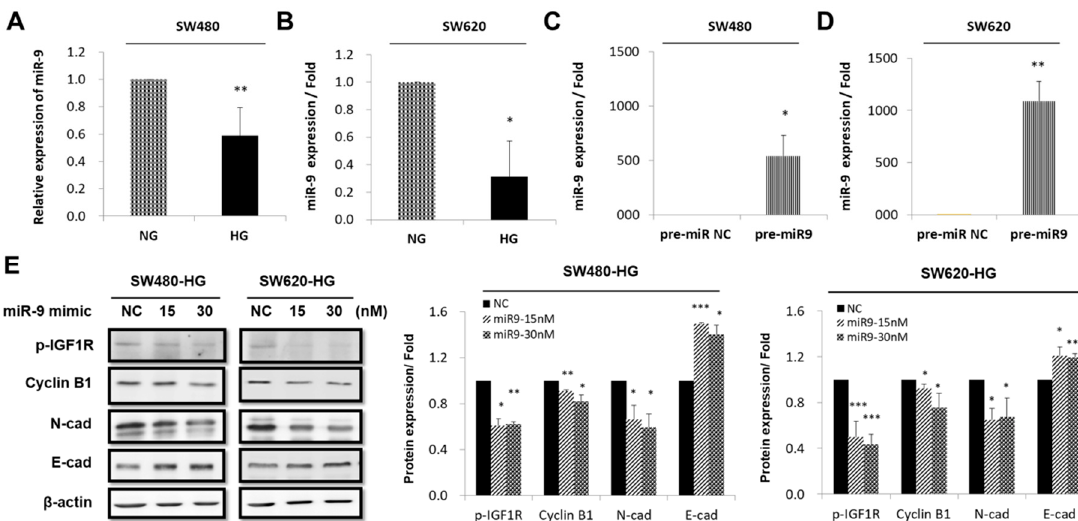
Figure 4. Expression and regulation of miR-9 in colorectal cancer (CRC) cell lines by high glucose (HG) concentration. TaqMan quantitative real-time polymerase chain reaction analysis was performed on miR-9 in SW480 and SW620 CRC cell lines that were cultured in different concentrations of glucose: Namely NG (5.5 mM D -glucose) and HG (25 mM D -glucose). In HG-concentration medium, miR-9 was decreased in both ( A ) SW480 ( p < 0.005) and ( B ) SW620 ( p < 0.05). All data were analyzed using a relative quantification method (2 − ∆∆ Ct ) with RNU6B small RNA as an internal control. ( C ) SW480 and ( D ) SW620 cells were transfected with pre-miR-9 at different doses (15 and 30 nM) or pre-miR negative control (NC) for 48 h in HG-concentration medium. ( E ) Western blotting validated the downregulation of p-IGF1R, cyclin B1, and N-cadherin as well as the upregulation of E-cadherin expression through pre-miR-9 overexpression, compared with pre-miR NC. β -actin was evaluated as an internal control. Statistically significant differences between the two groups were judged using Student’s t -tests, * p < 0.05, ** p < 0.005, *** p < 0.001; n.s. = nonsignificant.